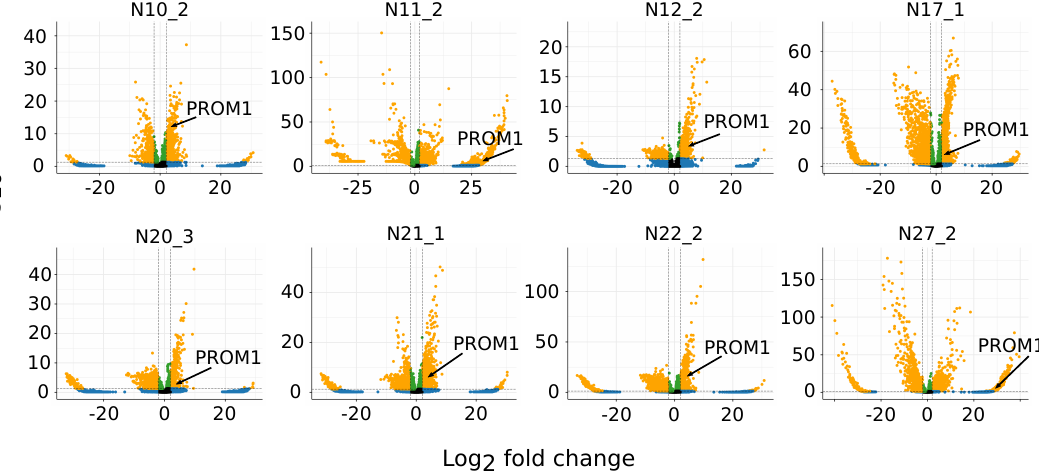
Figure 1. Volcano plot of the 8 clusters marked by PROM1 . The number following the underscore of each title is the cluster ID. See Table S1 for the original names of the samples. The stippled lines represent the marker genes criteria: p -value < 0.05, and logFC > 2. Selected marker genes are the yellow dots on the right side of the volcano plot. For clusters N10_2, N11_2, N12_2, N17_1, N20_3, N21_1, N22_2, and N27_2, PROM1 ranks 66/702 (top 9.4%), 5499/5901 (top 93.2%), 236/917 (top 25.7%), 1269/2181 (top 58.2%), 628/764 (top 82.2%), 315/891 (35.3%), 152/739 (top 20.6%), and 1524/2943 (top 51.8%),